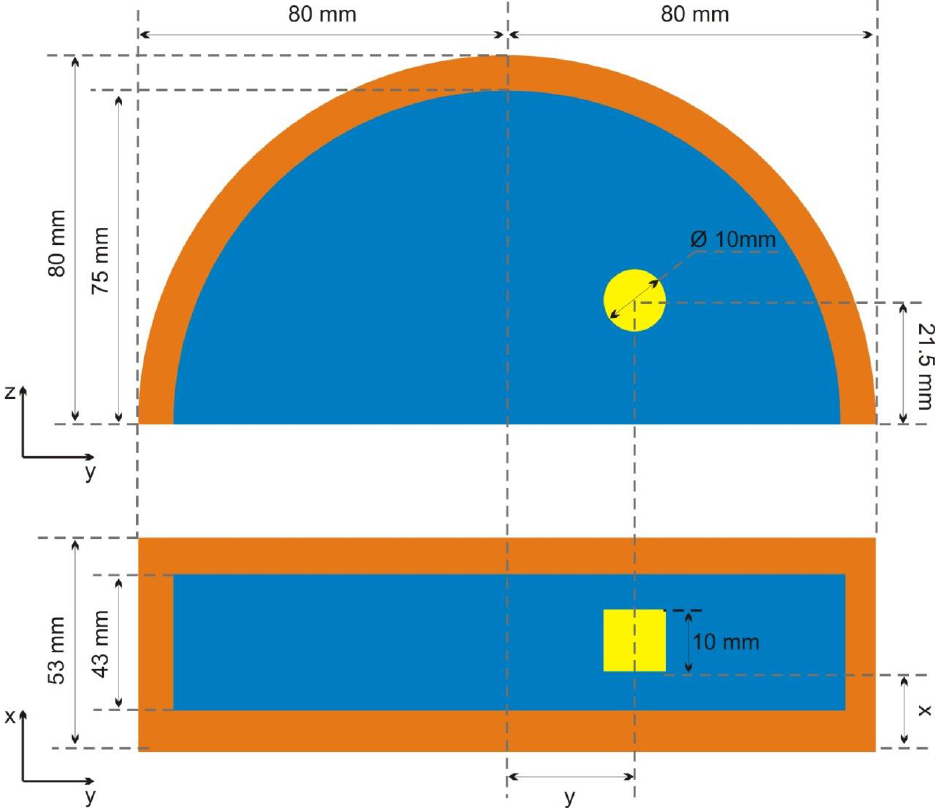
Figure 4. The virtual breast phantom model with a thickness h p of 53 mm. Visible external (orange) and internal (blue) parts, as well as an element imitating a cancerous tumor (yellow), are shown. The outer part, with a thickness of 5 mm, was made of adipose tissue, and the inner part consisted of a mixture of glandular and adipose tissue in the proportions determined by the level of glandularity (Table 2). The composition of the simulated tissues and the density of adipose tissue ( ρ a ) and glandular tissue ( ρ g ) were determined based on the work of Hammerstein et al. [30]. It was assumed that the neoplastic tissue has the same compo- sition as the glandular tissue, but it is characterized by a higher density ( ρ t ) [31,32]. De- tailed data on the elemental composition and tissue density are presented in Table 3. Table 2. Typical values of glandularity corresponding to breasts of a given thickness after compres- sion according to the European Guidelines for Quality Assurance in Breast Cancer Screening and Diagno- sis (4th Edition) [33]. Thickness of Breast (mm)